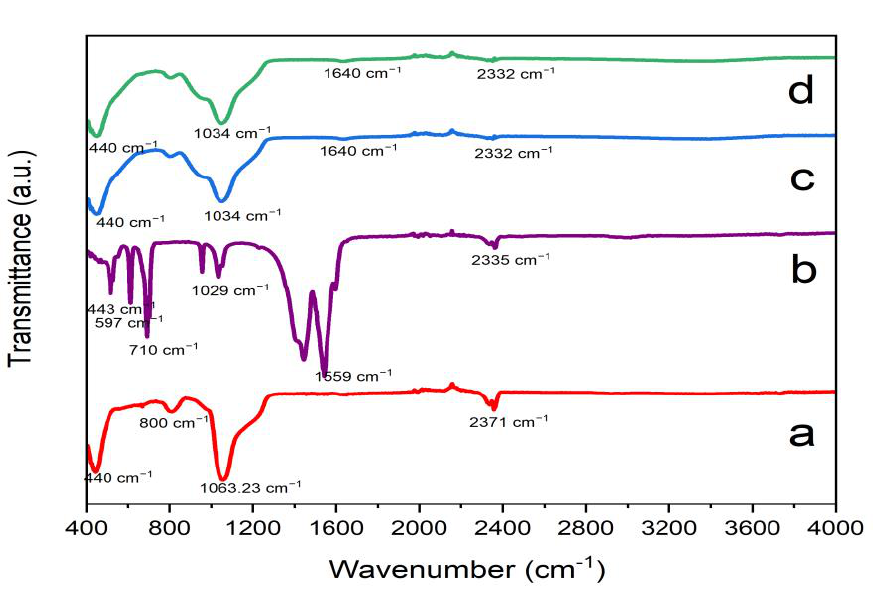
Figure 3. FTIR spectra of the as-prepared ( a ) SBA-15 supports; ( b ) ZnO; ( c ) ZnO/SBA-15; and ( d ) Ru-ZnO/SBA-15 composites.